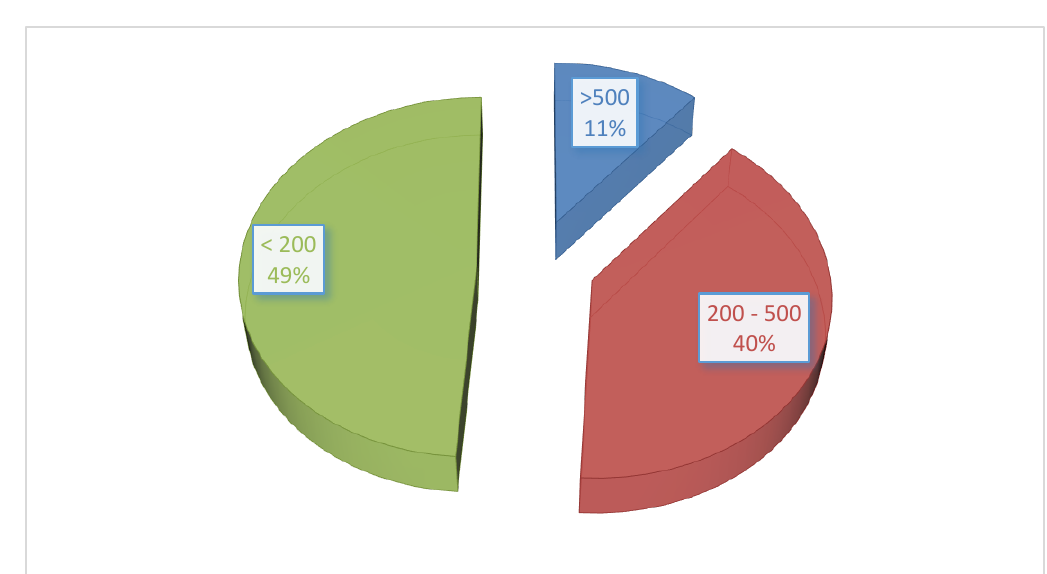
Fig. 2. Distribution according to CD4 counts.